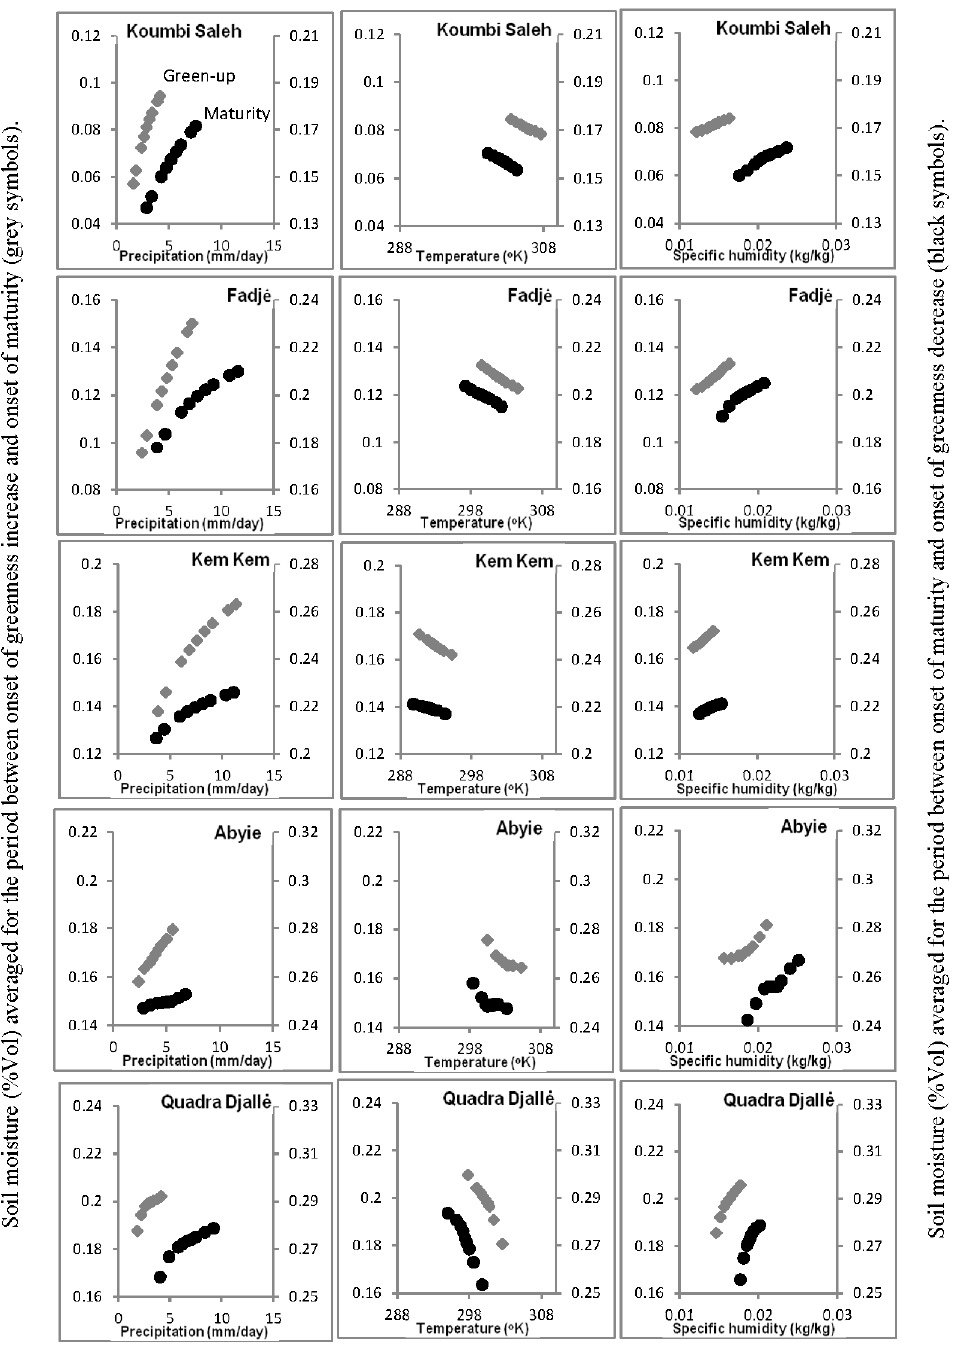
Figure 12. The response of daily soil moisture at root depth to changes in precipitation, temperature, and specific humidity averaged for the period from green-up to maturity (green-up period, grey diamonds; left hand axis) and from maturity to senescence (maturity period, black circles; right hand axis). Note the different ranges on the y axis between sites.